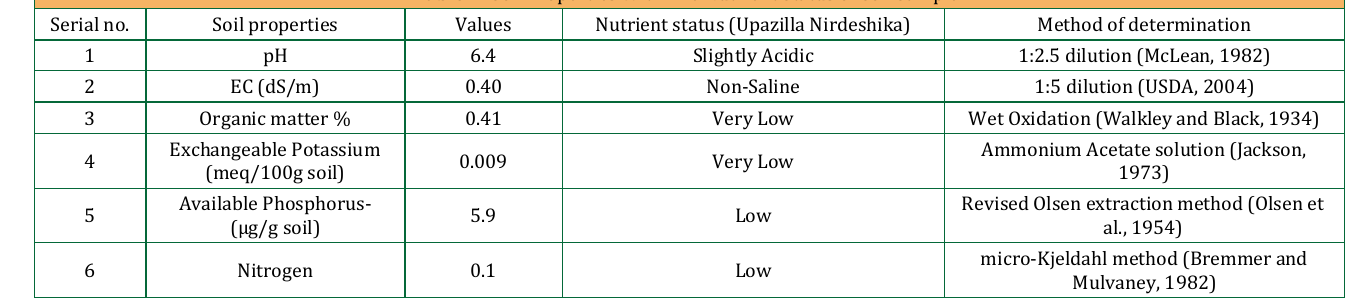
Table 1: Soil Properties With The Nutrient Status of Soil Sample-